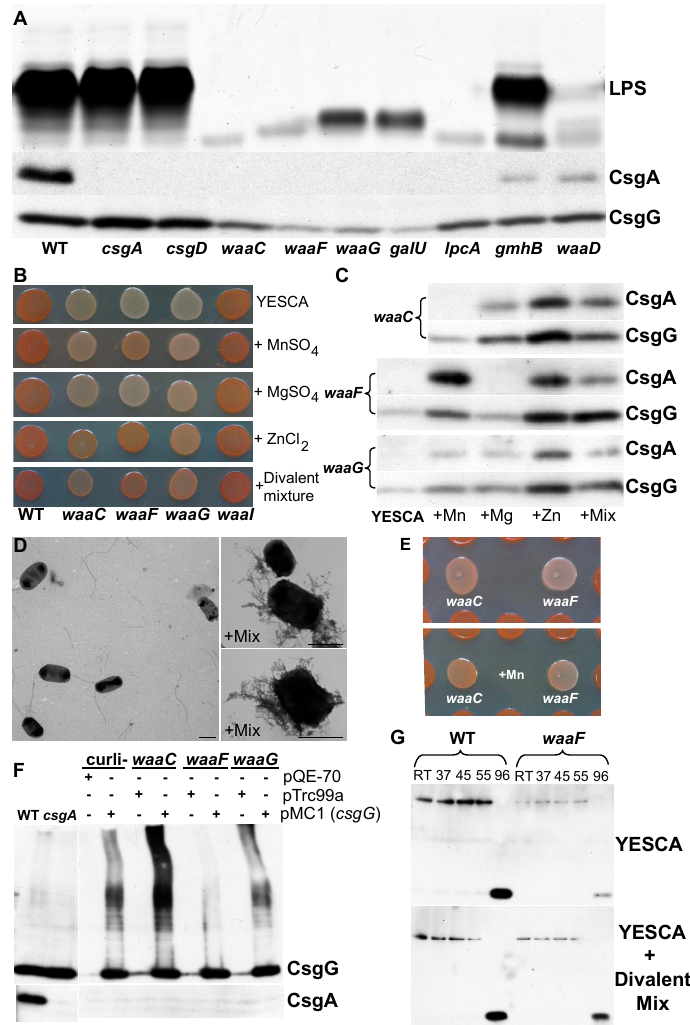
Figure 4. Effects of inner core LPS mutants on curli production. ( A ) Silver stain of LPS from LPS mutants and BW25113 (WT) resolved on a 14% polyacrylamide gel electrophoresis (PAGE) Tricine gel (top panel), and the respective whole cell Western blots probed with antibodies to CsgA and CsgG are shown in the bottom part of panel A. ( B ) Addition of divalent salts MnSO 4 (0.5 mM), MgSO 4 (0.5 mM), ZnCl 2 (0.1 mM), or a mixture of all three divalent and CaCl 2 (0.5 mM) to CR indicator plates had varying abilities to suppress the CR phenotype of the indicated LPS mutants. ( C ) Whole cell Western blots of LPS mutants probed with anti-CsgG and anti-CsgA antibodies. All samples were grown on YESCA plates supplemented with the indicated salts at 26 ◦ C for two days and treated with hexafluoroisopropanol (HFIP). ( D ) Transmission electron microscopy (TEM) images of waaF grown on YESCA and YESCA amended with a mixture of divalent cations. Scale bar equals 1 µ M. ( E ) The addition of 2 µ L of 0.1 M MnSO 4 to LPS mutants waaC and waaF resulted in their ability to bind CR only when they were grown on plates surrounded by BW25113. ( F ) Overexpression of csgG from pMC1 did not rescue CsgA secretion in inner core LPS mutants. ( G ) The CsgG of WT (BW25113) and